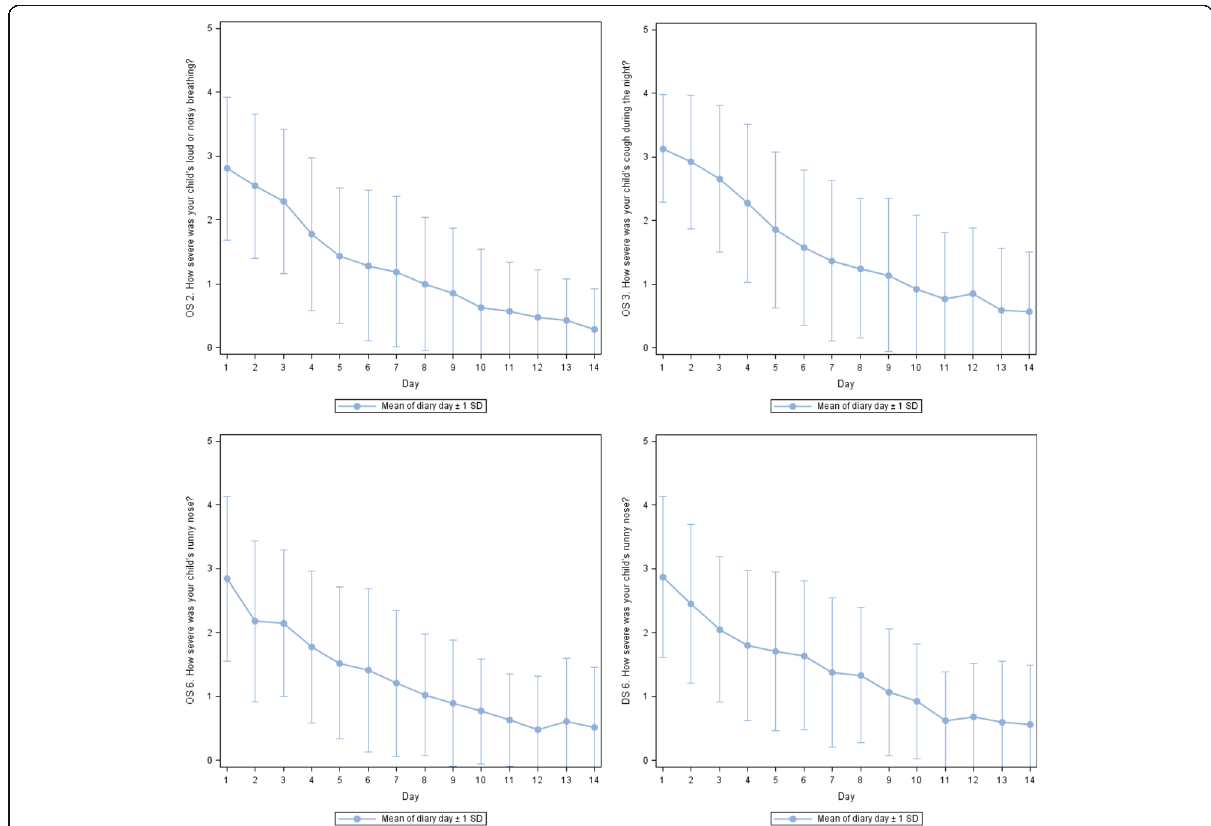
Fig. 1 Item-level line plots displaying average item scores for four items over the course of the study, SD standard